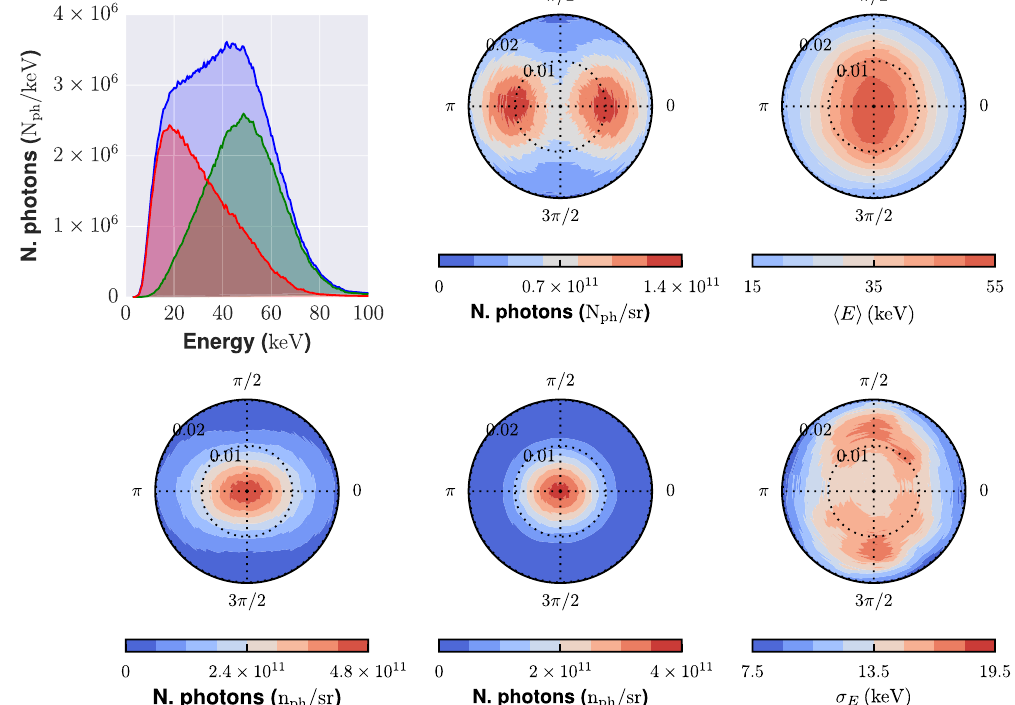
Figure 2. Spectral and angular distributions of the X-ray photons from the all-optical Thomson scattering source as retrieved using the TSST simulation code. The polar ( ϑ ) and azimuthal ( ϕ ) angles are defined in Fig. 1. Left column , top : photon spectra integrated over the whole polar angle 0 ≤ ϑ ≤ 20 mrad (blue curve), over the polar range 0 ≤ ϑ ≤ 10 mrad (green curve) and over the polar range 10 ≤ ϑ ≤ 20 mrad (red curve). Left column, bottom : angular distribution of the X-ray photons (integrated over the whole energy range). Middle column : photon angular distributions, taking into account only “low-energy” photons (0 ≤ E ph ≤ 40 keV), top , or “high- energy” photons (40 ≤ E ph ≤ 80 keV), bottom . Right column : Angular map of the average photon energy ( top ) and of the photon energy standard deviation ( bottom ). The angular maps span an azimuthal ( ϕ , as shown in Fig. 1) range 0 ≤ ϕ ≤ 2 π and a polar angle ( ϑ ) range 0 ≤ ϑ ≤ 20